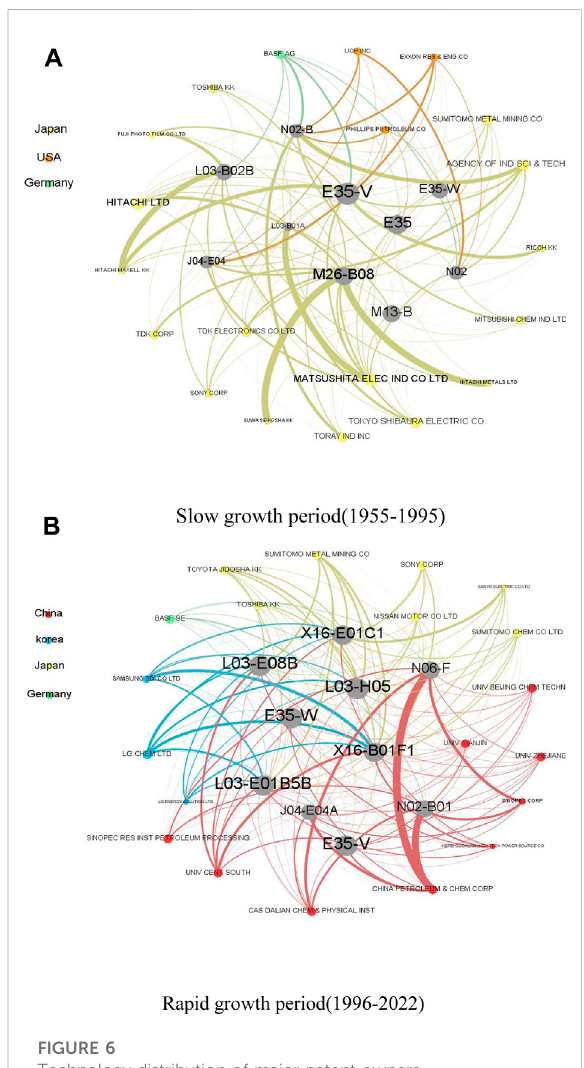
FIGURE 6 Technology distribution of major patent